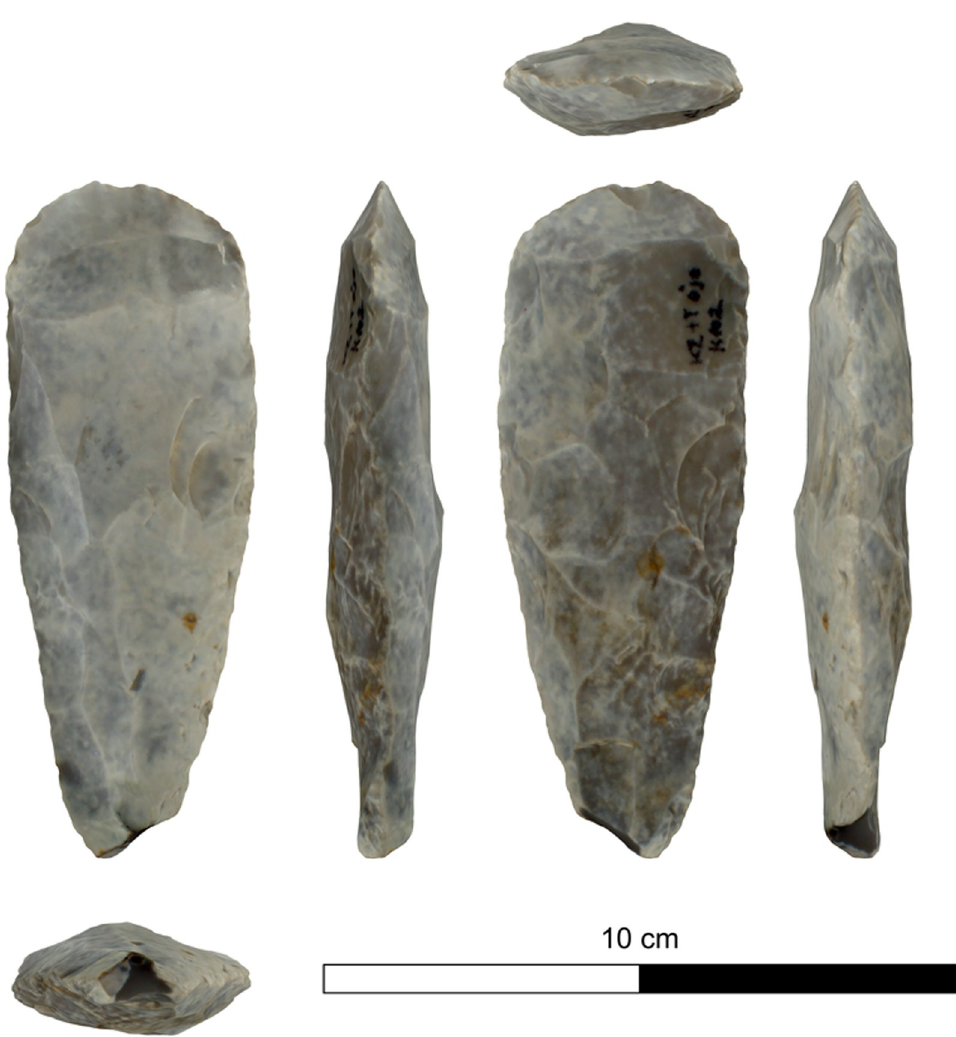
Fig 25. Finely made biface (a ‘prestige item’)